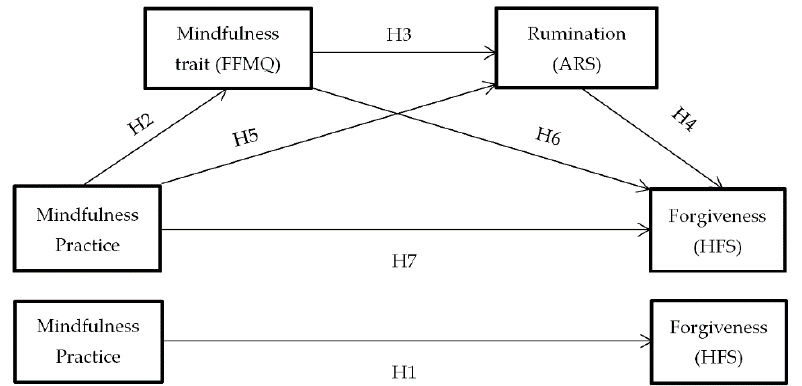
Figure 1. Hypothesized mediation model: Spillover effect of mindfulness practice on forgiveness. H1–H7: Hypothesis 1–Hypothesis 7.